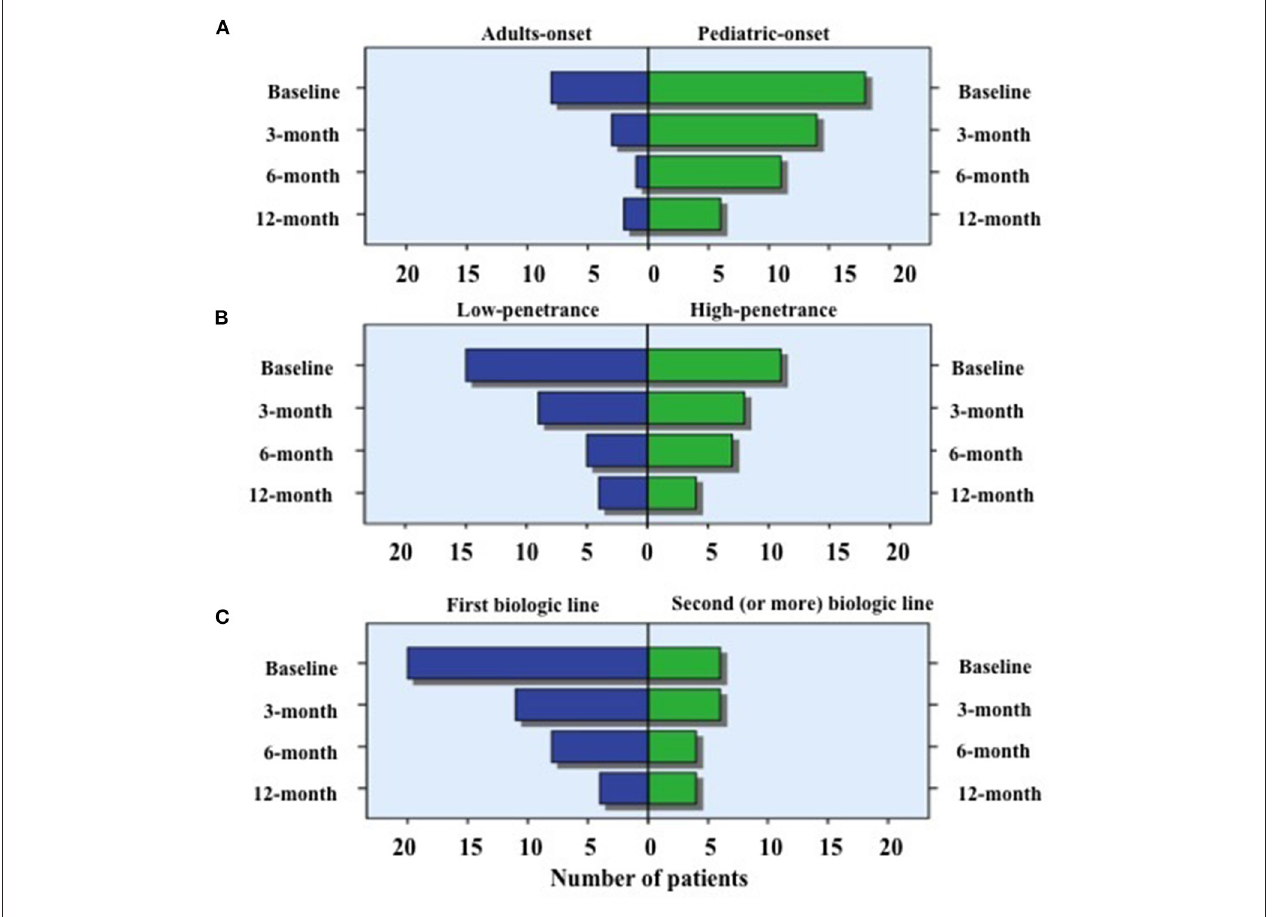
FIGURE 6 | Use of corticosteroids in specific subgroups of patients. Number of patients requiring the use of corticosteroids at the different time-points, distinguishing biologic treatment courses according to: (A) the age at TRAPS onset (adult vs. pediatric onset); (B) penetrance of mutations (high- vs. low-penetrance) and (C) the line of biologic agents (first line vs. second or more line). As also reported in the text, the number of patients discontinuing corticosteroids was statistically significant higher in adult-onset TRAPS patients when compared to pediatric-onset patients at 3-month ( p = 0.01) and 6-month ( p = 0.02) assessments. Conversely, neither statistically significant difference was observed according to the different age at onset at the 12-month visit nor between subjects carrying low-penetrance and high-penetrance mutations or based on the biologic treatment line at the 3, 6, and 12-month